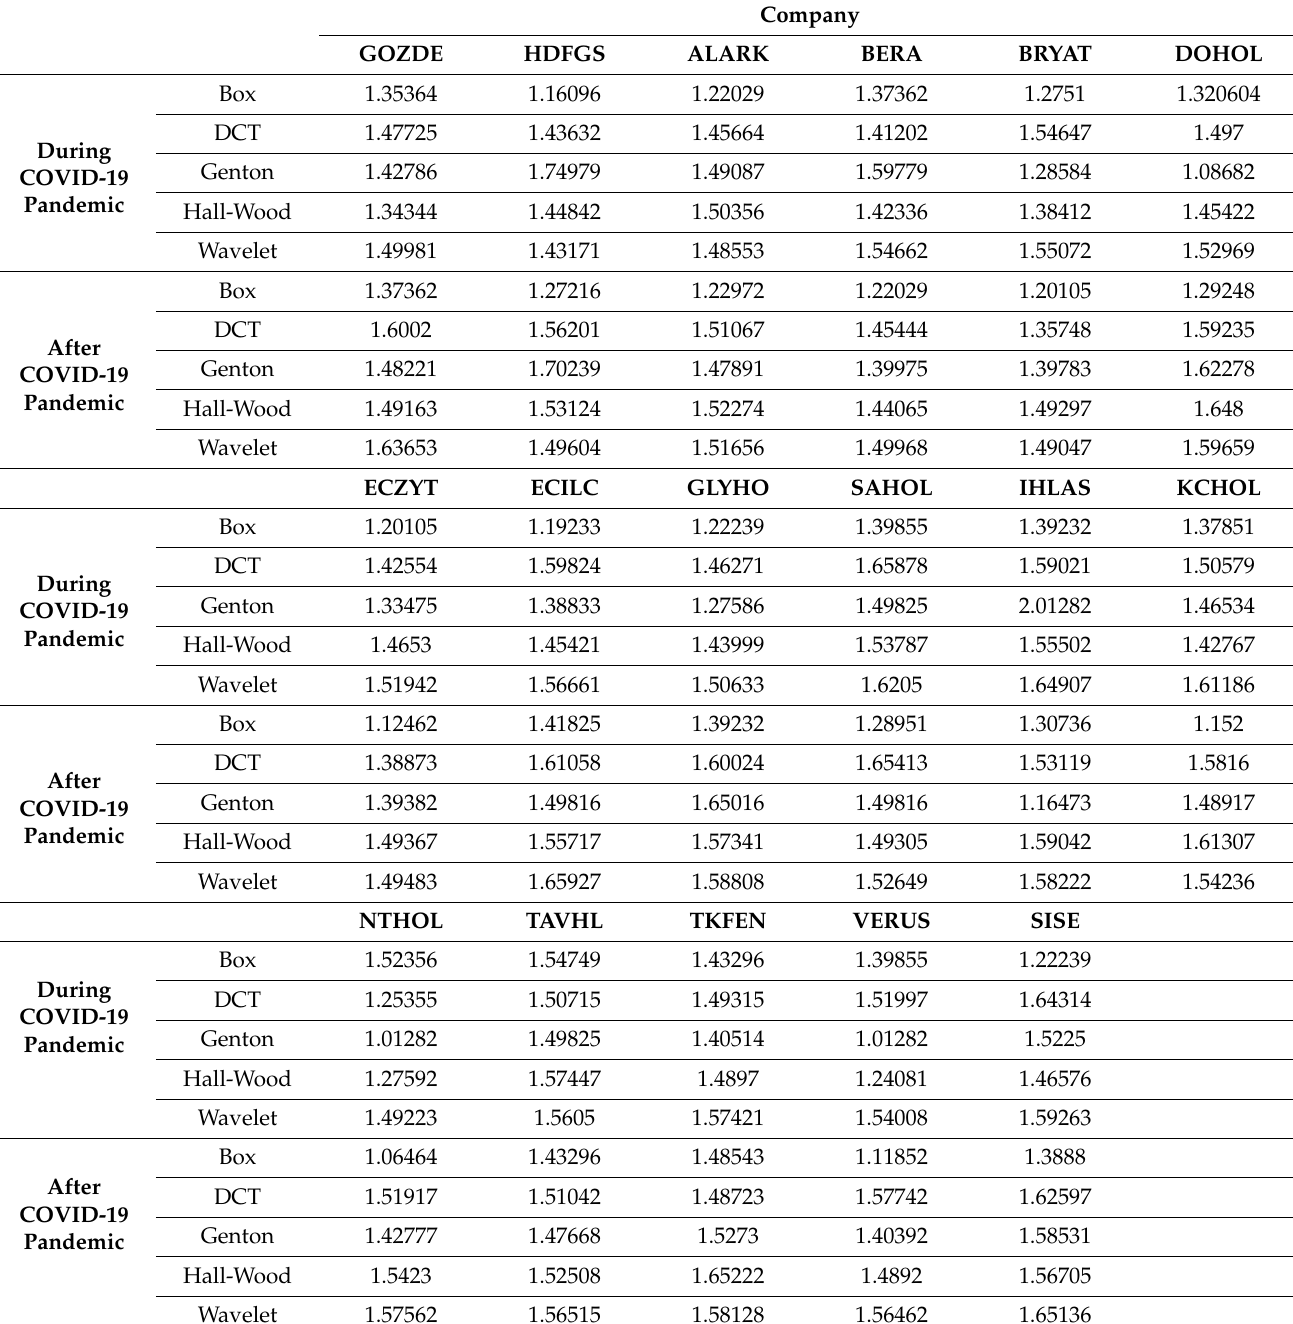
Table A11. Fractal dimensions for the holdings–investment companies